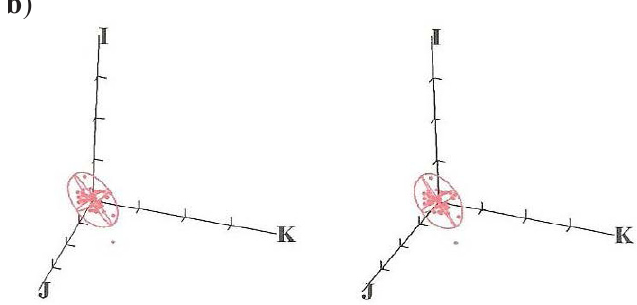
Figure 5: Stereo-pair scatter plots in symmetric dioptric power space for the anterior ( a ) and posterior ( b ) corneal keratometry for Subject 5.